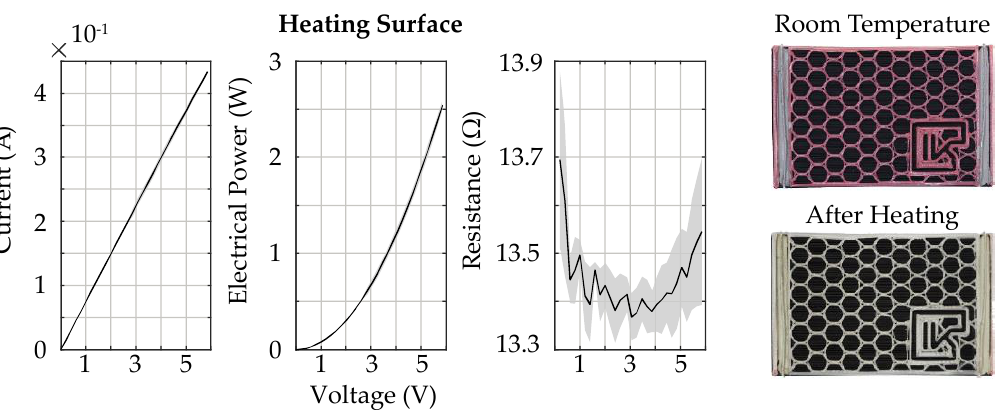
Figure 21. Representation of current, electrical power and resistance depending on voltage of the incorporated heating surface and the color change depending on the temperature.